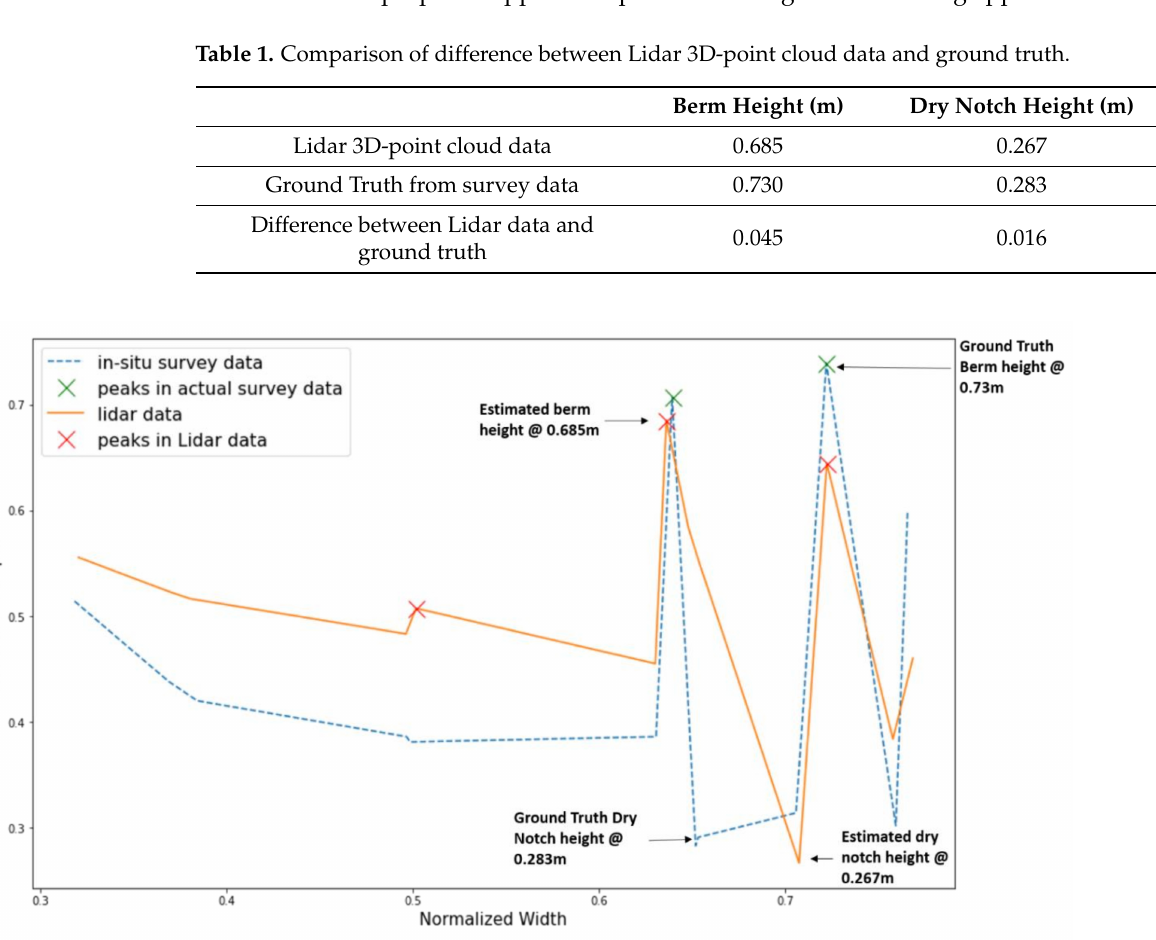
Figure 12. Sand berm height comparison between ground truth and Lidar point cloud